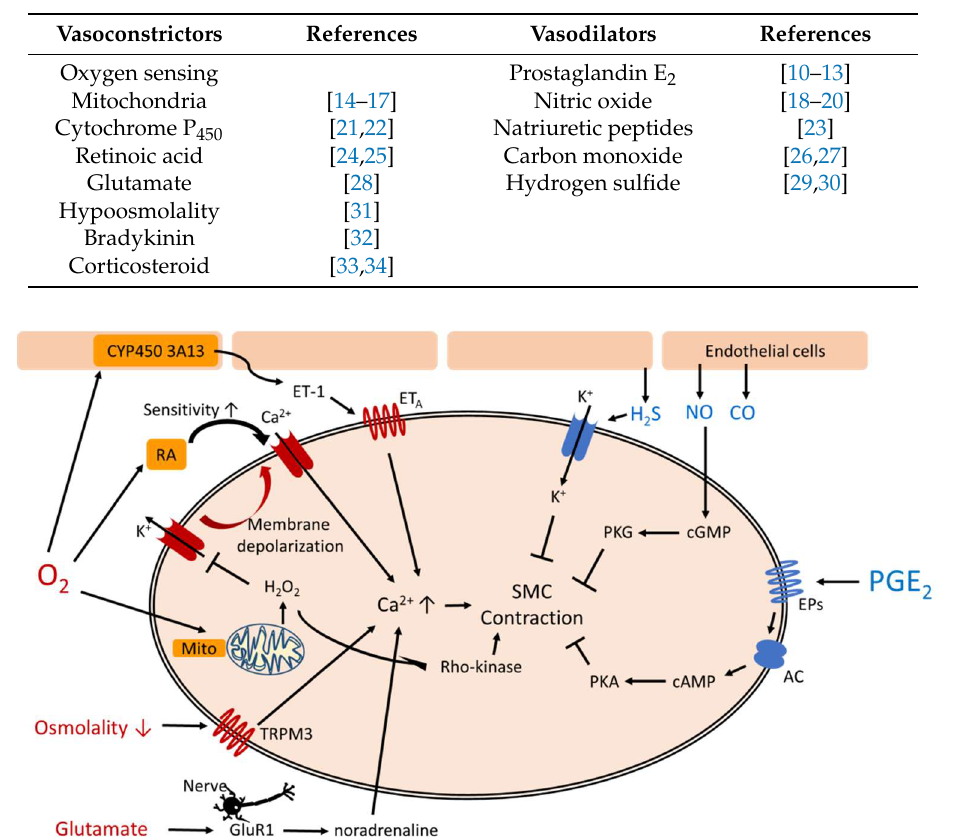
Figure 1. Pathways mediating functional closure of the ductus arteriosus. AC: adenylyl cyclase, cAMP: cyclic adenosine monophosphate, cGMP: cyclic guanosine monophosphate, EPs: PGE 2 receptors, ET: endothelin, GluR1: glutamate inotropic receptor subunit 1, Mito: mitochondria, PGE 2 : prostaglandin E 2 , PKA: protein kinase A, PKG: protein kinase G, RA: retinoic acid, SMC: smooth muscle cells, TRPM3: transient receptor potential melastatin 3.